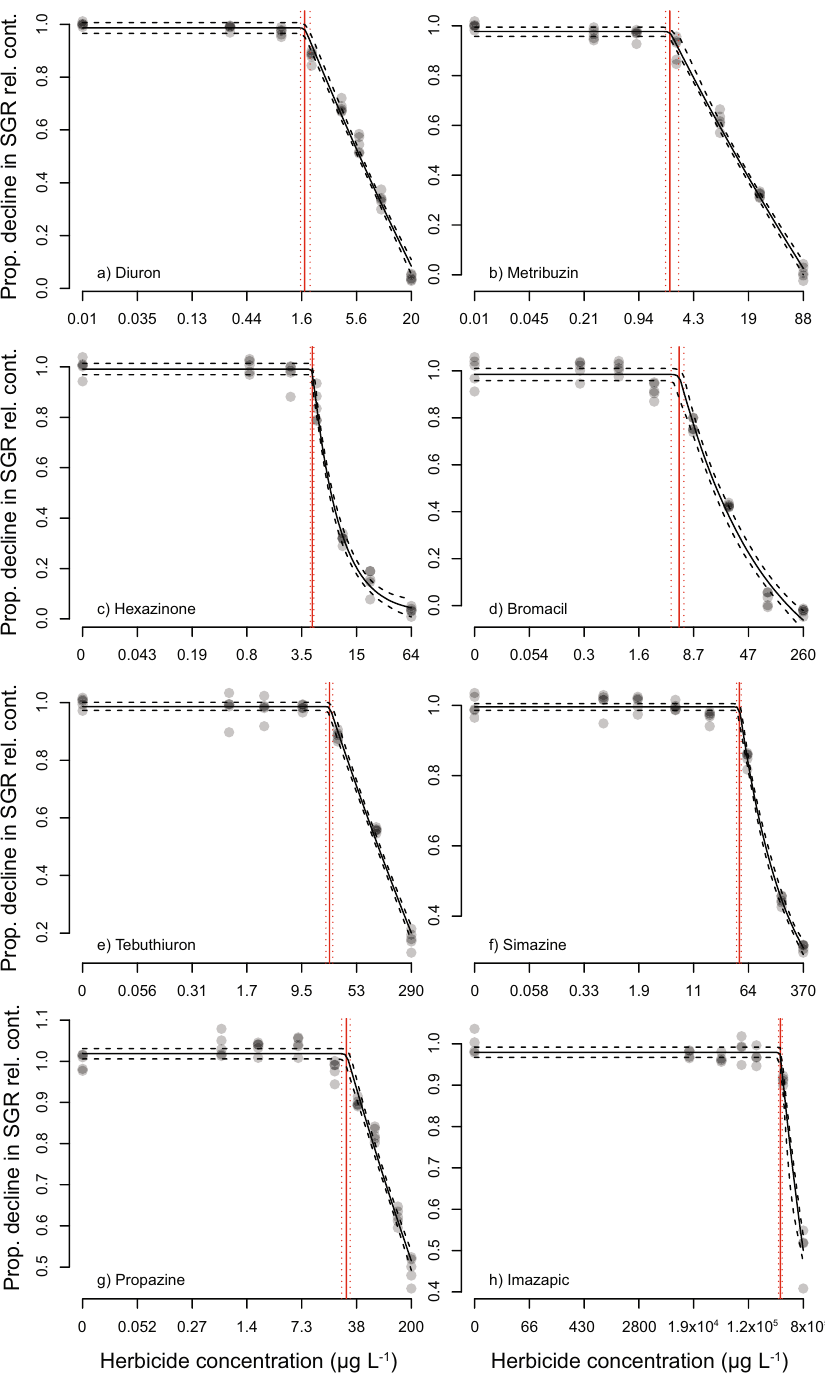
Figure 2. Concentration-response curves for NEC derivation. Bayesian non-linear gaussian model fit on the proportional decline in 3-day specific growth rate (SGR) relative to the control treatment (solid black line) and 95% confidence interval (black dashed line) to derive the no effect concentration (NEC) (red line) and 95% confidence interval (red dashed line) of ( a ) diuron; ( b ) metribuzin; ( c ) hexazinone; ( d ) bromacil; ( e ) tebuthiuron; ( f ) simazine; ( g ) propazine; and h) imazapic. All concentrations in µ g L − 1